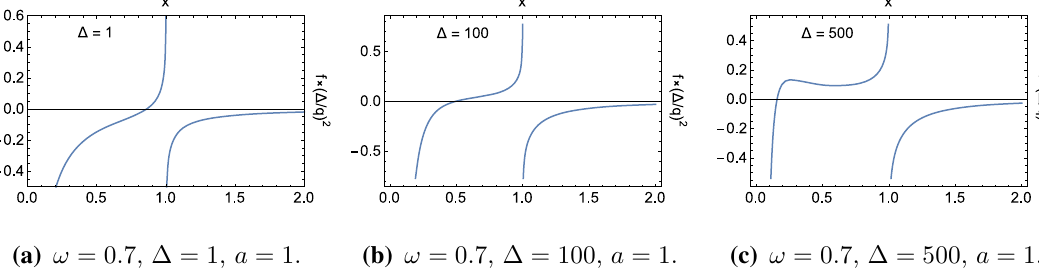
Fig. 2 Dimensionless self-force f × ((cid:14)/ q ) 2 in terms of the dimensionless coordinate x , for different sizes (cid:14) of the conical region. The throat is at x = 0 and the exterior shell is at x = 1